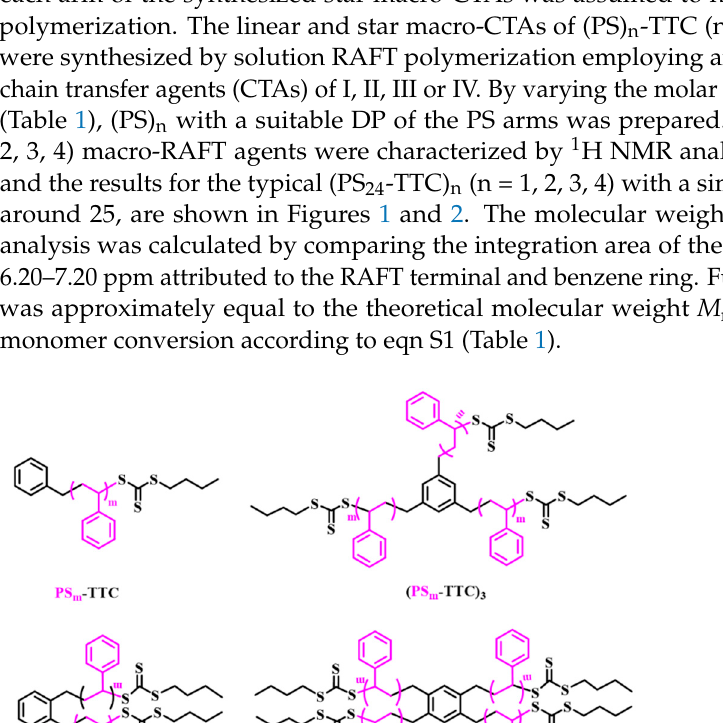
Figure 1. 1 H NMR spectra of (PS-TTC)n (n = 1, 2, 3, 4) with similar PS arms chain at about 25. Figure 2. GPC traces of PS-TTC)n (n = 1, 2, 3, 4) with similar PS arms chain at about 25. 3.2. Effect of the Arm Number on BCP Nanoassemblies Prepared through PISA It has been reported that the arm number of star polymers has an important effect on the morphology of block copolymer nanoassemblies in ethanol/water. However, the topology of star polymers on the morphology of nanoassemblies formed through PISA in toluene has not been studied. To achieve this, we synthesized a series of (PS- b -P4VP) n nanoparticles with different compositions by varying the length of the PS or P4VP chain segments according to scheme S3, and characterized their morphologies by TEM.